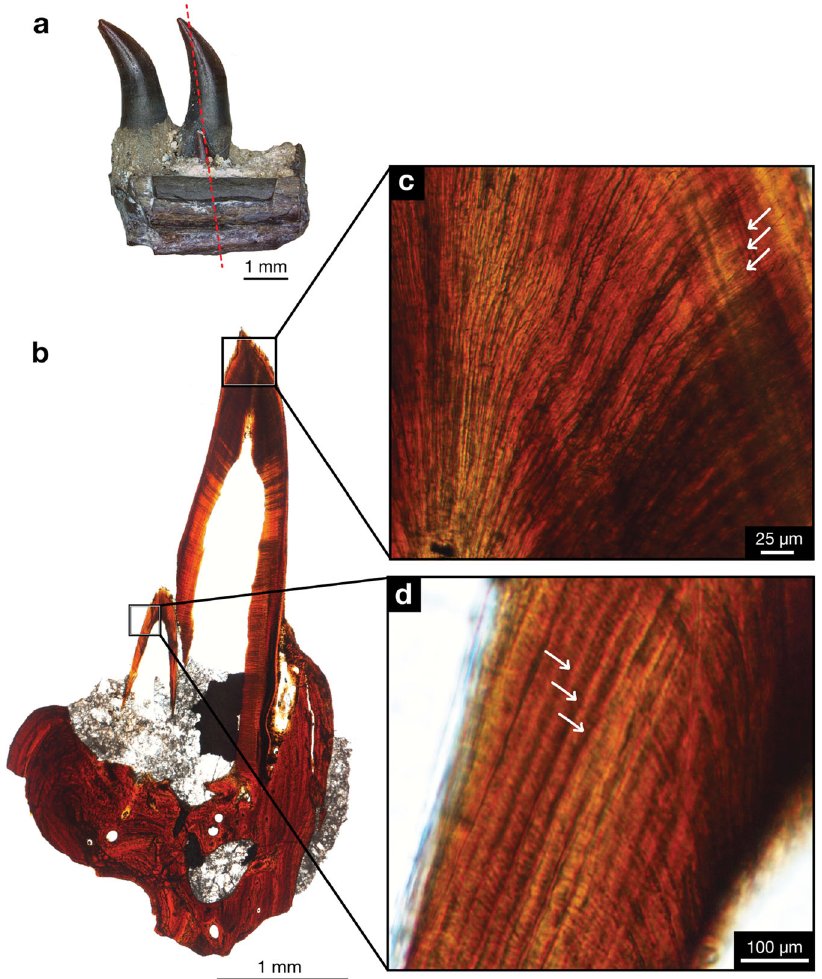
Fig.2|Incrementallinesof Mesenosaurusefremovi .a ROMVP85502,lingualview of fragmenteddentarywithdashed redlinesthroughtheplaneof theLLsectionof thefunctionalandreplacementteeth. b WholeviewoftoothfamilyLLsectionnear